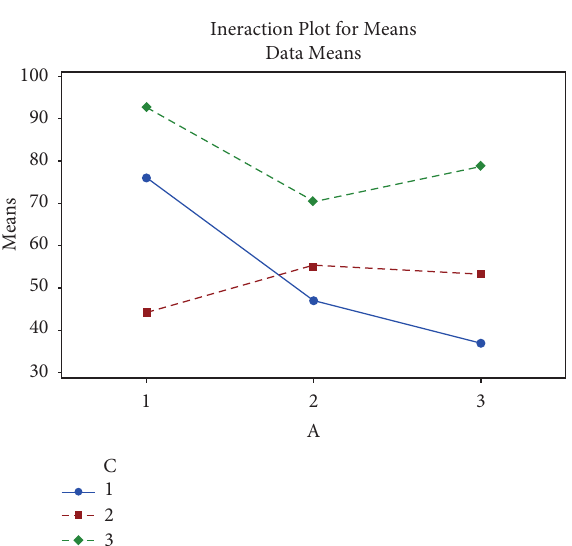
Figure 11: Effect of interaction between rotational speed and shoulder diameter ( A × C ) on average traverse force.